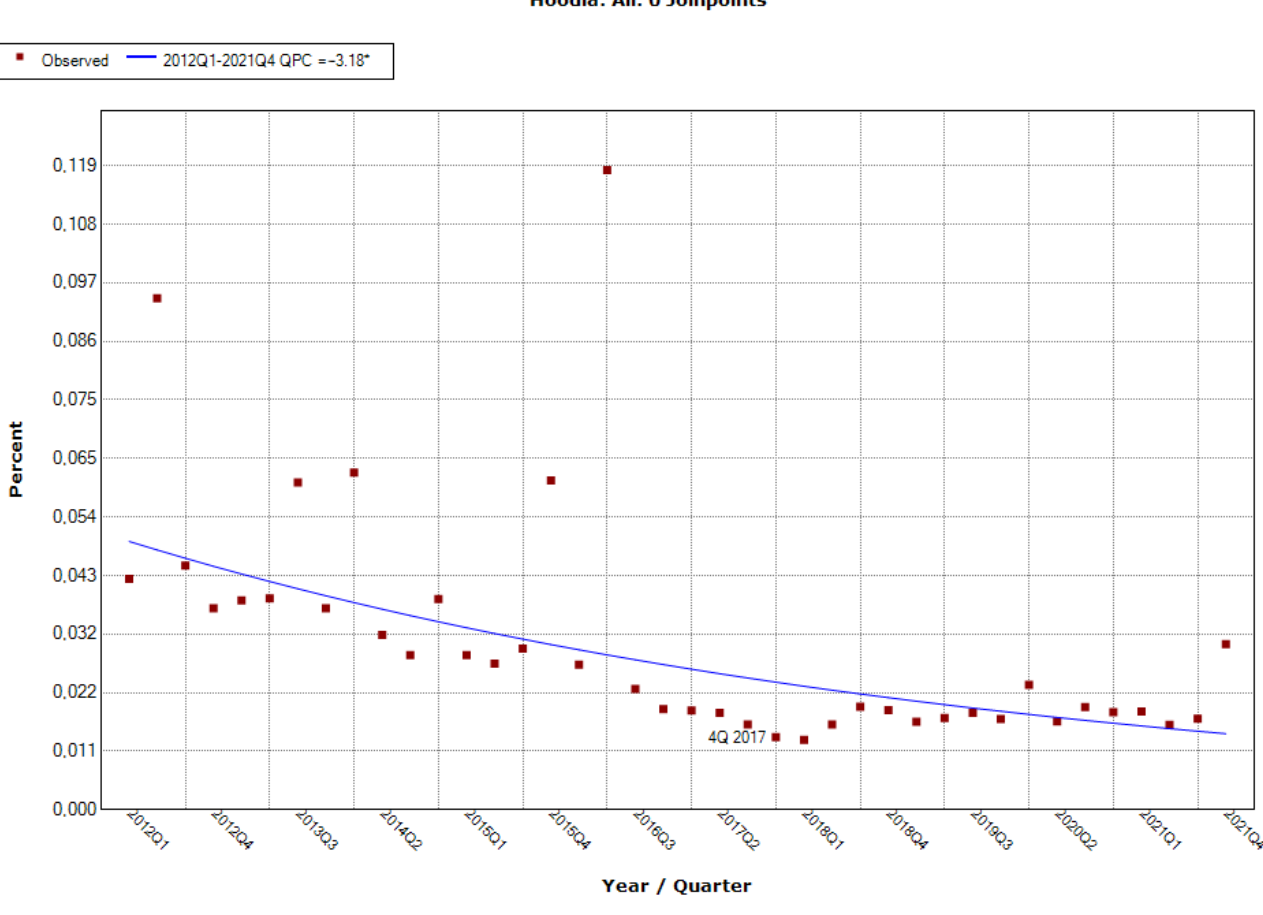
Figure A11. Percentage of products containing hoodia in individual quarters in the period from 2012 to 28 November 2021. Joinpoints mark trend turning points. The date above the observation indicates the moment of publication of the scientific opinion/resolution.